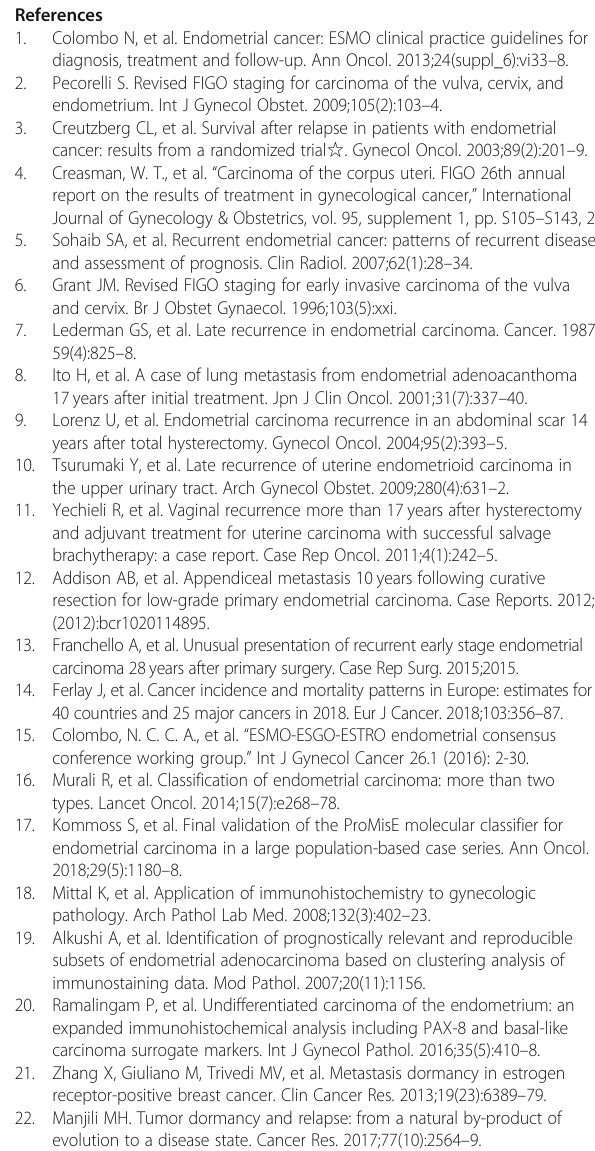
Abbreviations FIGO: Federation of Gynecology and Obstetrics; ER: Estrogen receptor; PAX8: Paired box 8; TTF-1: Thyroid transcription factor 1; SUV: Standardized uptake